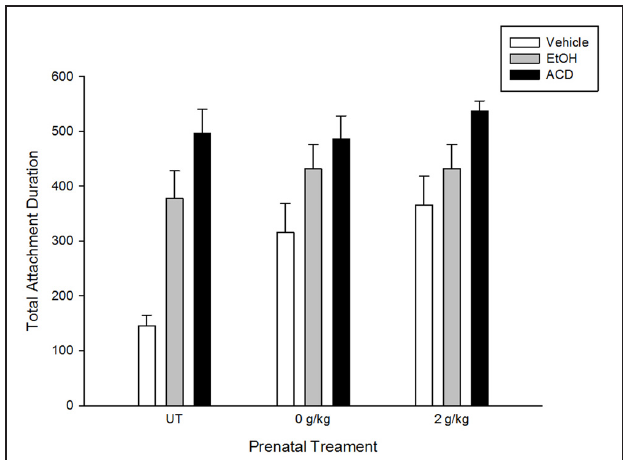
FIGURE 1 | Total attachment duration in naive newborns (untreated—UT—adapted from March et al., 2013a) and newborns prenatally exposed to water or ethanol (a dayly dose of 2g/kg during gestational days 17–20; adapted from March et al., 2013b). Newborns were trained in a clasical conditioning paradigm in which an aromitic cue was associated to a central administration of vehicle, ethanol, or acetaldehyde. Testing took place 1h later and consisted of presenting an artificial nipple aromatized with the conditioned